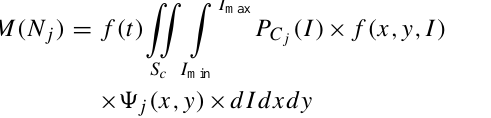
Table 1. Comparison of building vulnerability classes according to MMSK-86 and EMS-98. 1 Description of buildings’ types according to EMS-98